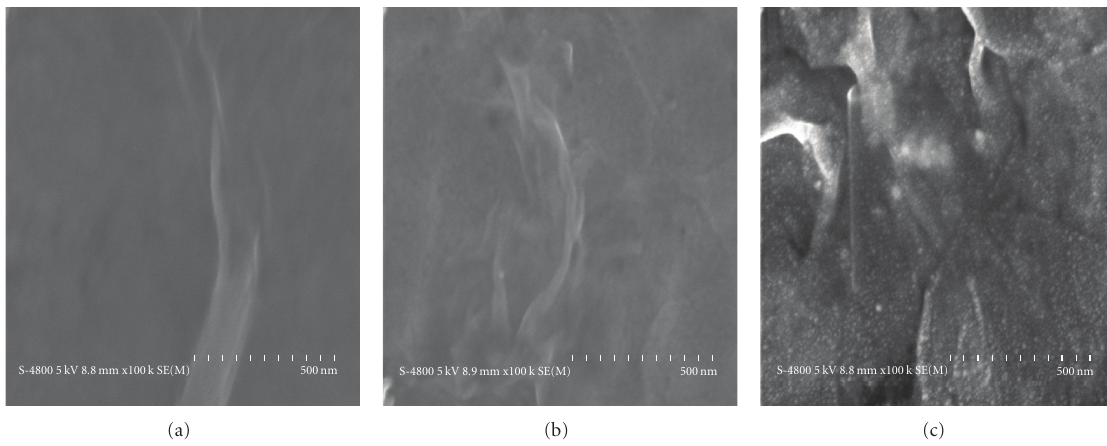
Figure 2: SEM image of (a) graphene oxide, (b) graphene, and (c) platinum nanopaticles on graphene.